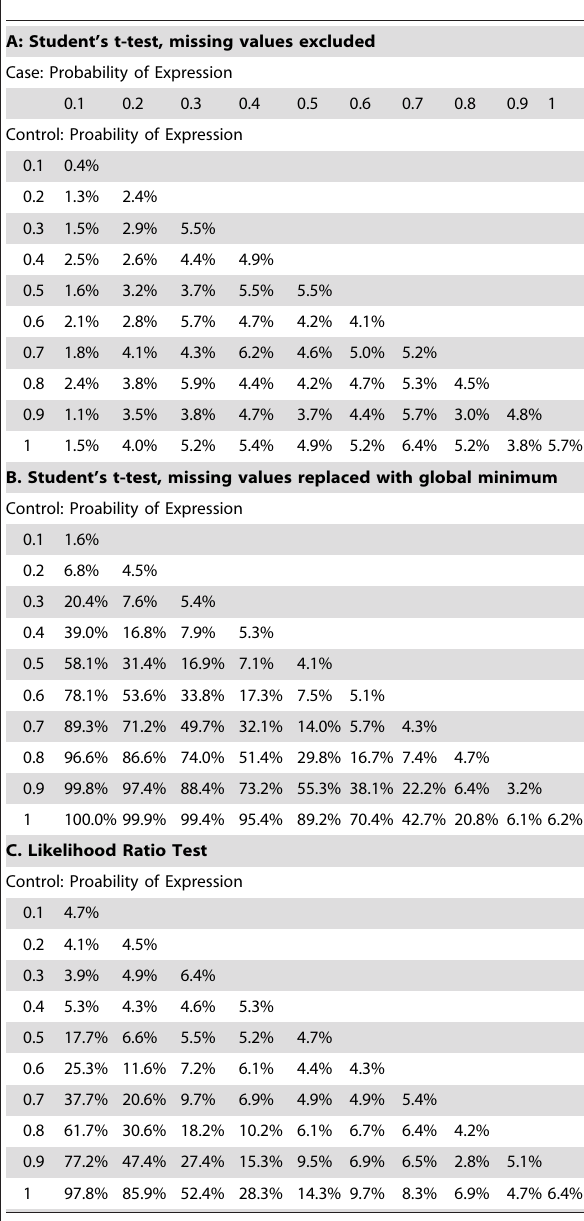
Table 1. Results for different mean expression intensities between groups with all spots expressed.